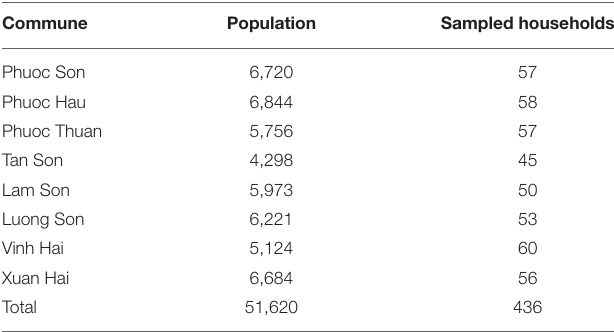
TABLE 2 | Sampling in districts of Ninh